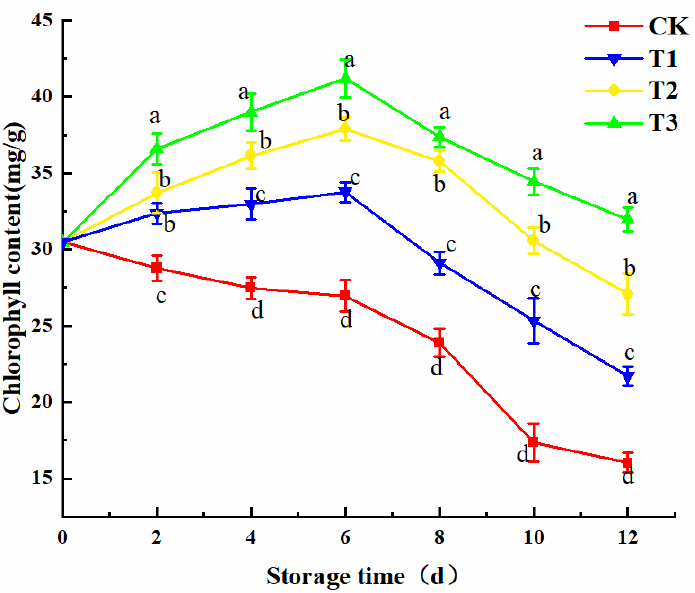
Figure 5. Changes in chlorophyll content. The means with different lowercase letters (a–d) in figure differ significantly ( p < 0.05).